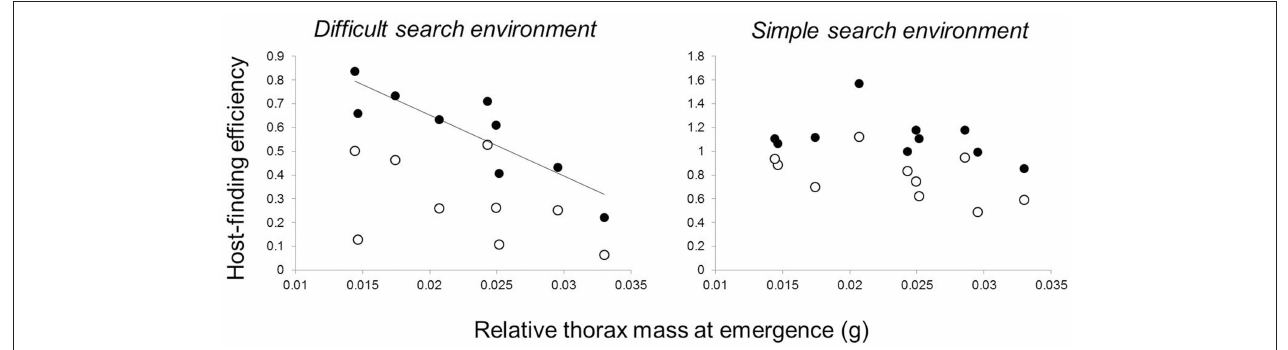
FIGURE 4 | Effectsofrelativethorax massonhost-finding efficiency. Each datapointrepresentsafull-sibling family.Host-findingefficiency (the proportionofsearching landingsonhostsvs.non-hosts,arcsine-square-root transformed)tendedtoincrease between naïve butterflies (opencircles—first 10landings ofa completely naïve hostsearch)andlater experience (closed